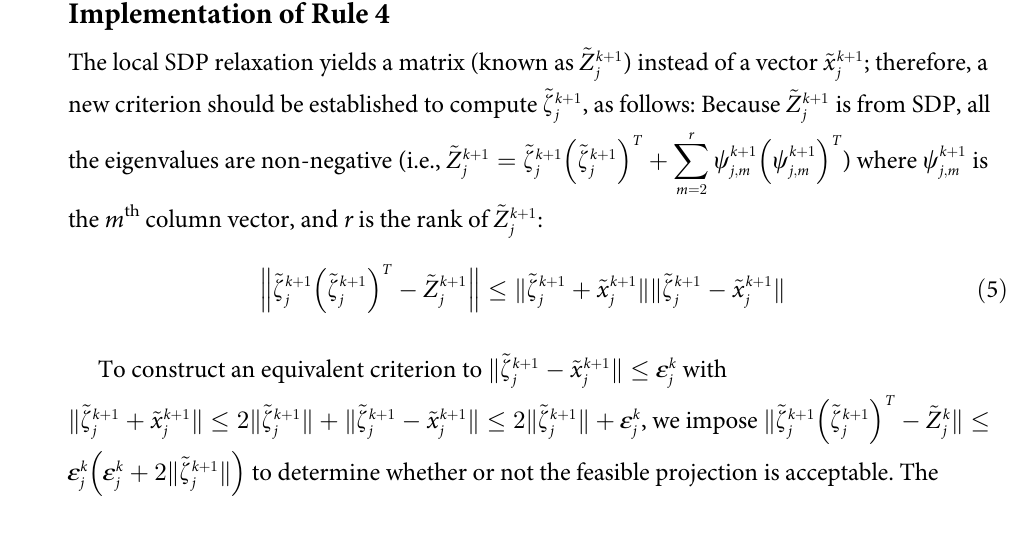
Fig 3. x -update from the result of optimization with 1) a feasible solution ~ x n þ 1 and the projection onto the feasible region is close enough k ~ z k þ 1 region is too far k ~ z m þ 1